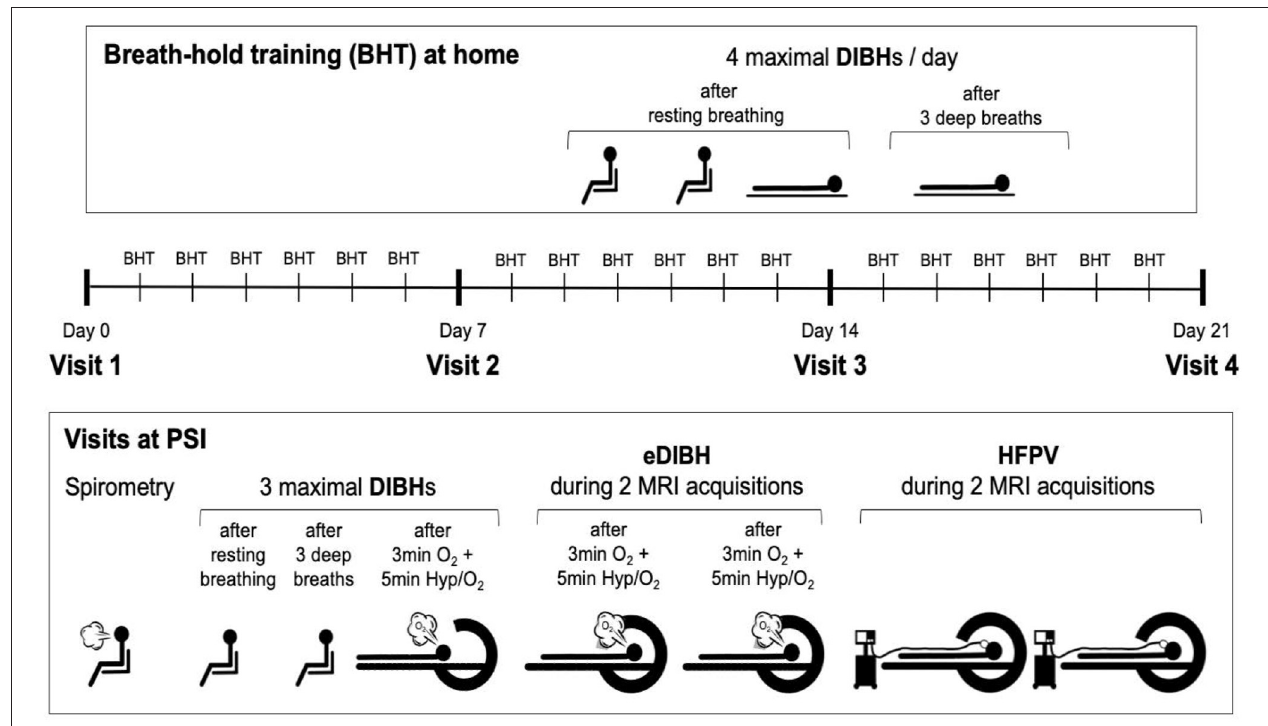
FIGURE 1 | Study protocol. Visits at the Paul Scherrer Institute (PSI) were interspersed by 6 days of home-based breath-hold training with four deep-inspiration breath holds (DIBHs) of maximal duration, two in sitting and two in supine position. The first three breath holds were performed out of resting breathing, the fourth after three deep breaths. At visits, first spirometry was performed, followed by two DIBHs of maximal duration in sitting position, the second one performed after three deep breaths. The third breath hold prior to magnetic resonance image (MRI) acquisitions was performed after ≥ 8min of breathing 100% O 2 with hyperventilation (at an end-tidal CO 2 -partial pressure of 20 mmHg) for the last 5min prior to this maximal enhanced DIBH (eDIBH). This procedure was immediately followed by moving the subject into the MR scanner, initiating the eDIBH-procedure prior to each of two consecutive MRI acquisitions and maintaining it during image acquisitions. After moving the subject out of the MR scanner and installing the high-frequency percussion ventilator (HFPV), the subject was moved into the scanner ring again for two consecutive MRIs under HFPV conditions.